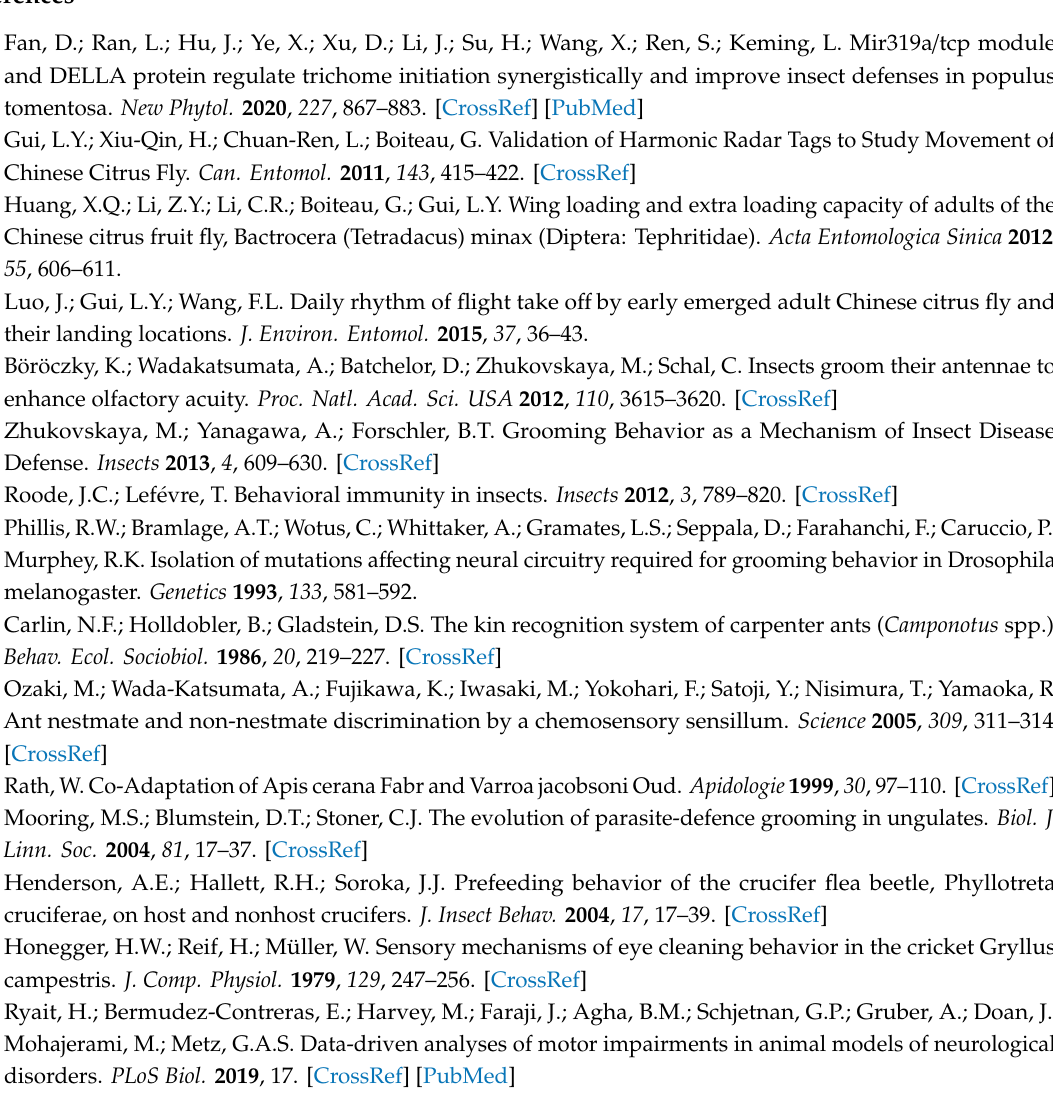
corresponding to abdomen grooming, Figure S6: The complete feature map after the third pooling corresponding The accuracy of each epoch of the other three detection